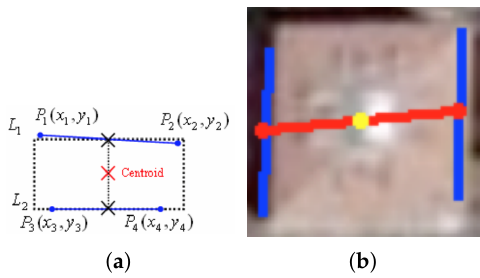
Figure 5. Figure 5a,b show the theoretical and real treatment of detected parallel lines,